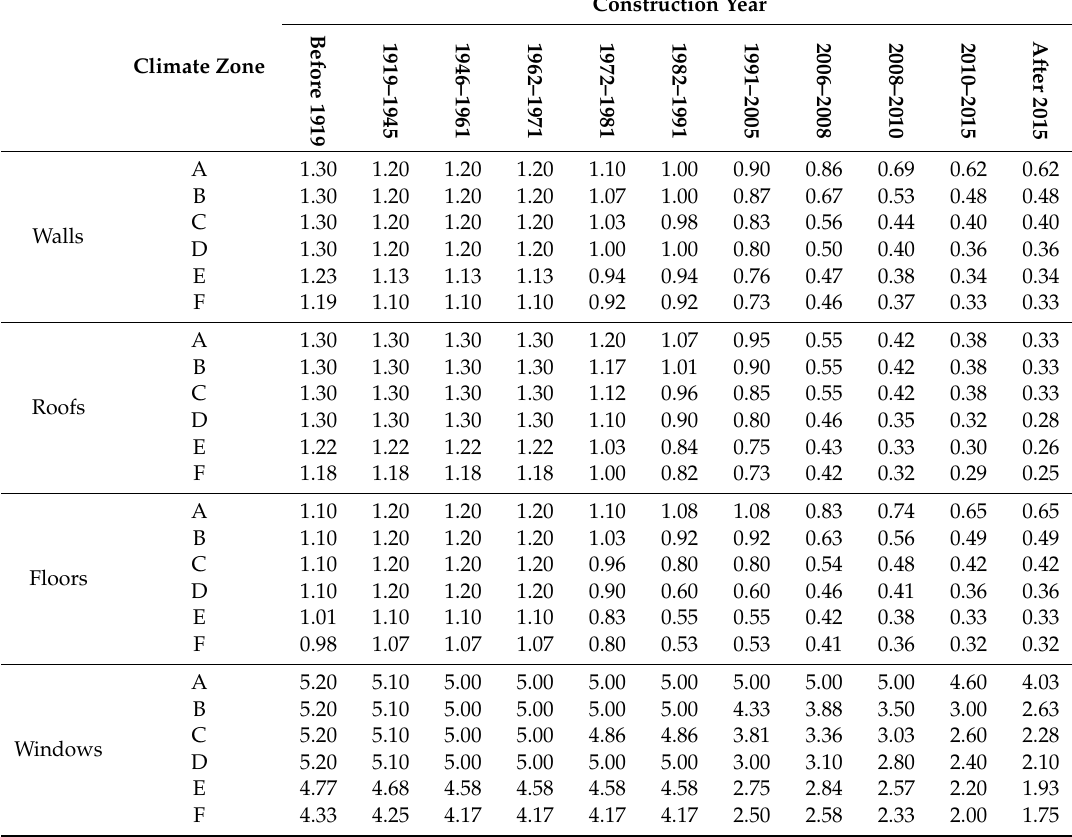
Table 4. Transmittance values depending on the construction year and the climate zone.